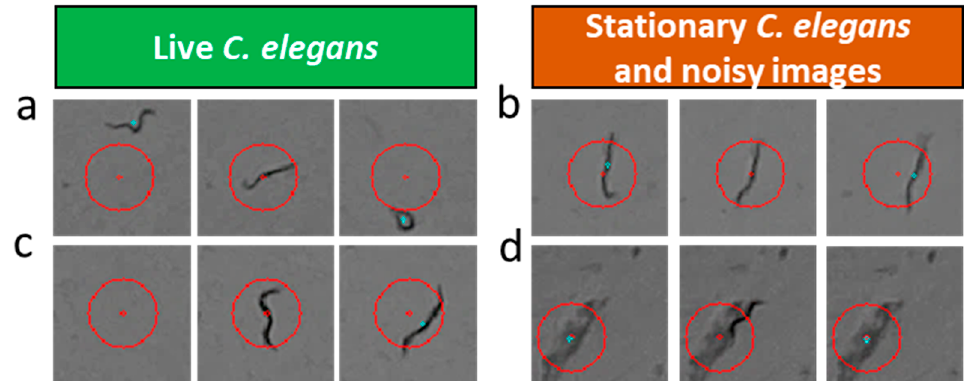
Figure 4. Examples of image sequences that can be classified with the initial detection method ( a , c ) and of the stationary ( b ) and noisy ( d ) images classified by the neural network. The red circle is centred on the centroid of the C. elegans /blob of the central frame and has a radius of 20 pixels. The blue dot is the centroid of the blobs detected in the remaining frames.